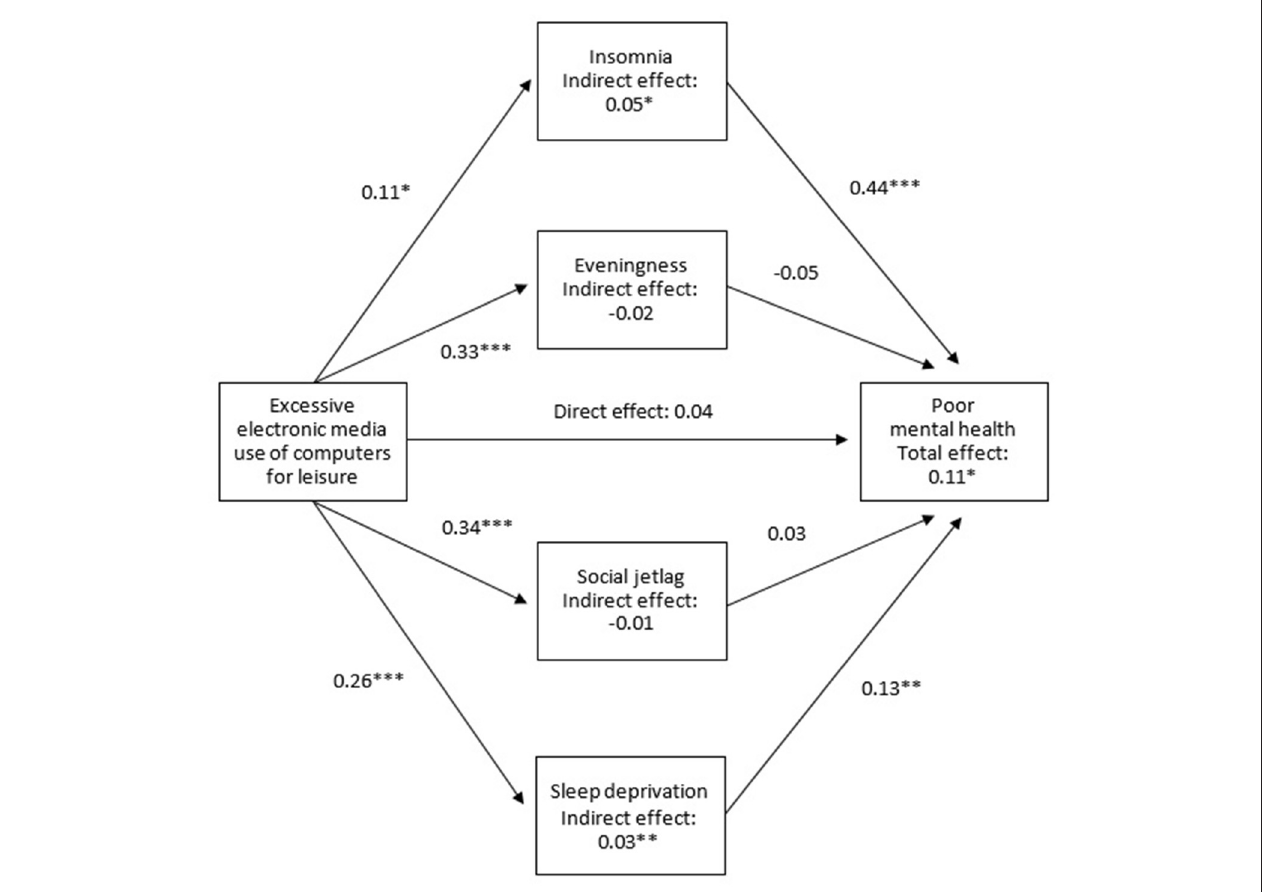
FIGURE 1 | An example of a path model of the association among EMU, sleep and circadian problems, and SEDB (Insomnia measured by the Insomnia Severity Index; Eveningness measured by the reduced Horne and Östberg Morningness and Eveningness Questionnaire; Mental health measured by the 12-item General Health Questionnaire; Adjusted for age, gender, and monthly family income; * < 0.05, ** < 0.01, *** <